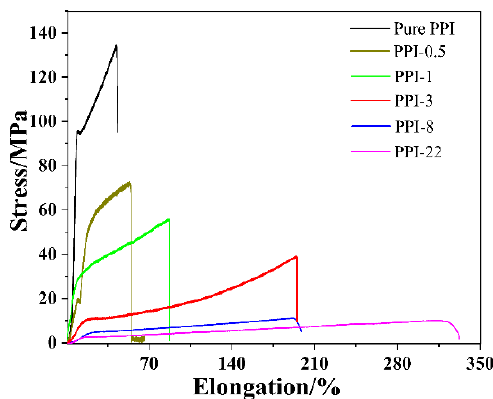
Figure 6. Stress ‐ Elongation curves of PPI and doped PPI membranes. Figure 6. Stress-Elongation curves of PPI and doped PPI